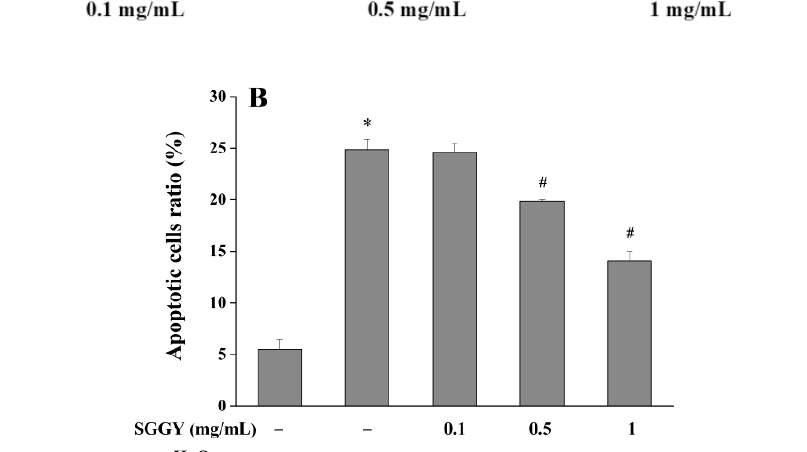
Figure 2. SGGY inhibited H 2 O 2 -stimulated apoptosis in SH-SY5Y cells. Cells were pre-incubated with SGGY (0.1, 0.5, and 1 mg/mL) for 12 h and subsequently exposed to 900 μM H 2 O 2 for 2 h. ( A ) Apoptosis was analyzed using Annexin V-FITC/PI staining by flow cytometry. The graphs contain the percentage of necrotic cells (Q1), late apoptotic cells (Q2), early apoptotic cells (Q3), and normal cells (Q4) relative to the total cells. (B ) Quantitative analysis of the apoptosis ratio of early and late apoptotic cells. ( C ) The expression of Bcl-2 and Bax were explored by Western blotting. * p < 0.05 vs. control group, and # p < 0.05 vs. H 2 O 2 group. 3.3. SGGY Ameliorated H 2 O 2 -Induced Redox Imbalances in SH-SY5Y Cells Compared to the control group, the level of intracellular ROS in SH-SY5Y cells was significantly upregulated after exposure to H 2 O 2 ( p < 0.05; Figure 3A,B). However, pre-